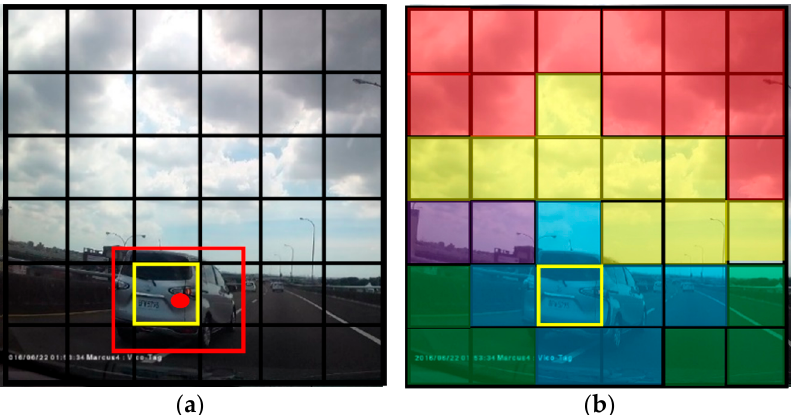
Figure 4. Deciding the class of the bounding box. ( a ) Prediction bounding box; ( b ) the class probability map.